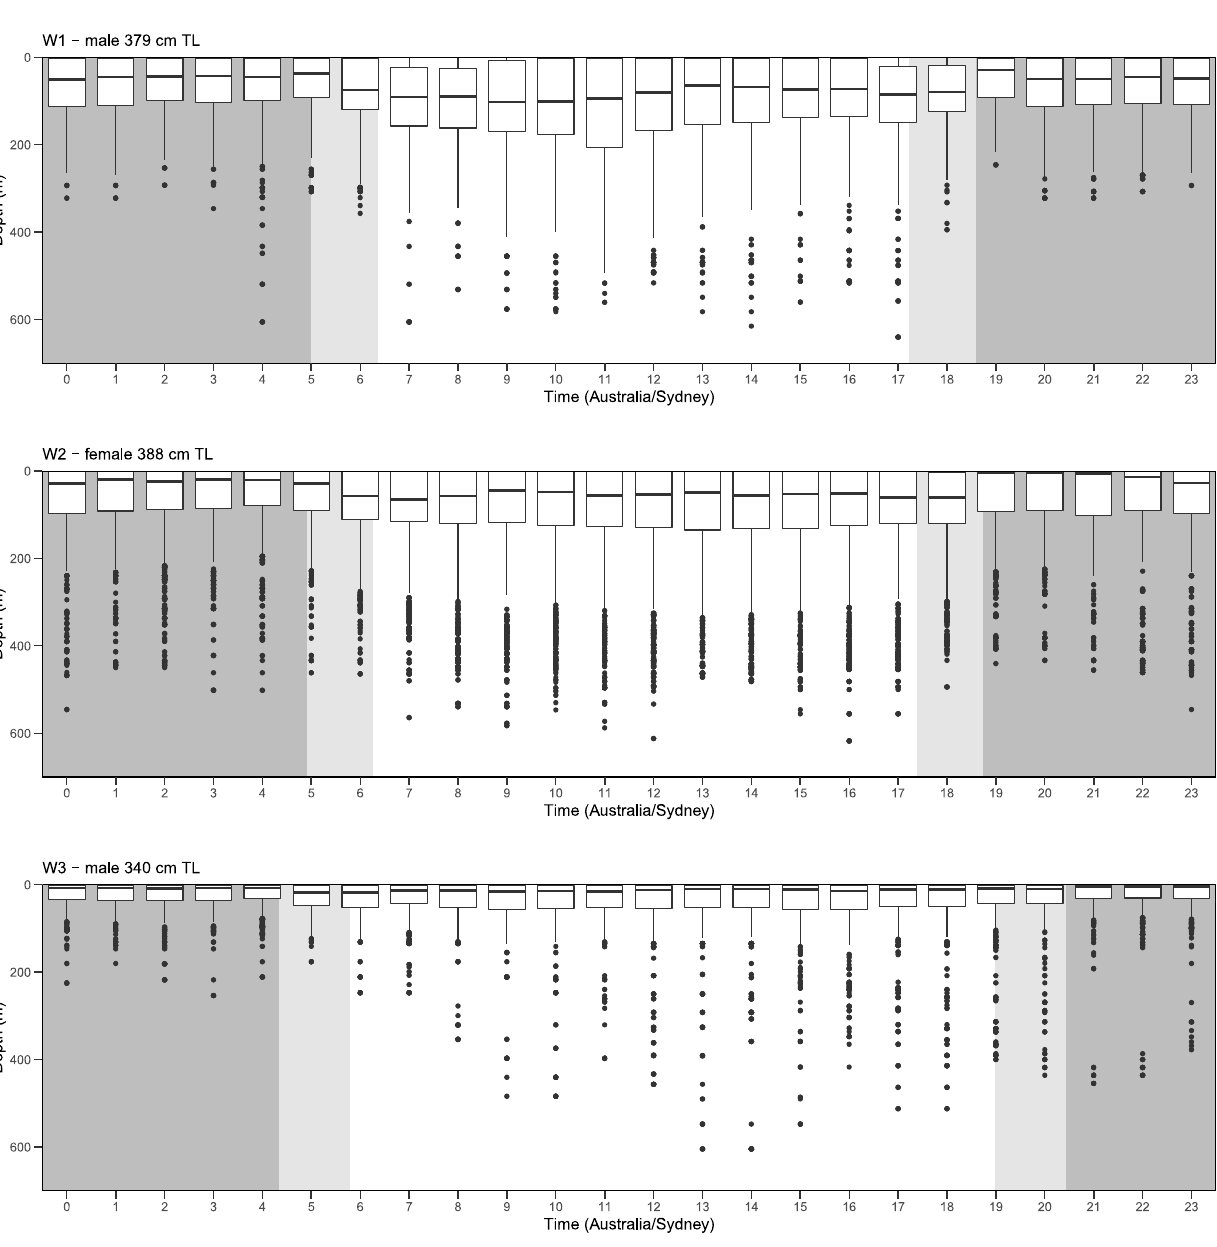
Figure 6. Mean depths (m) of three white sharks ( C. carcharias ) ( a ) W1, ( b ) W2 and ( c ) W3 plotted over a 24-h period (0–23 h AEST). White areas indicate daylight. Areas shaded in grey indicate night-time (darker grey) and twilight (lighter grey) periods.